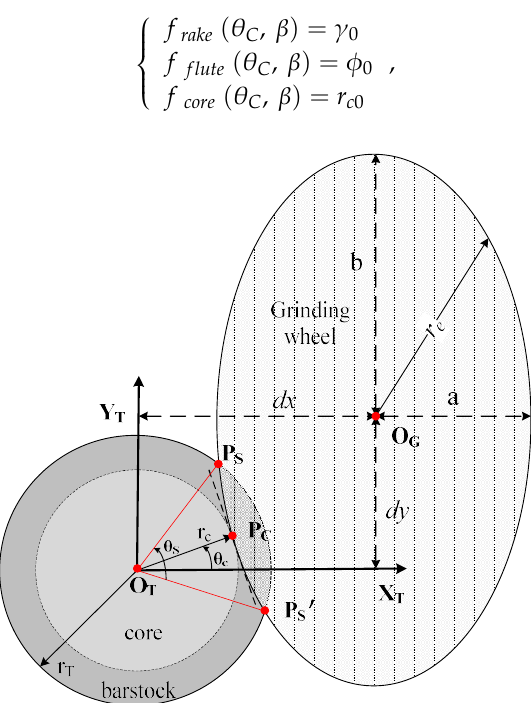
Figure 5. Illustration of the projection of the wheel edge and cutter profile within the cross-section.